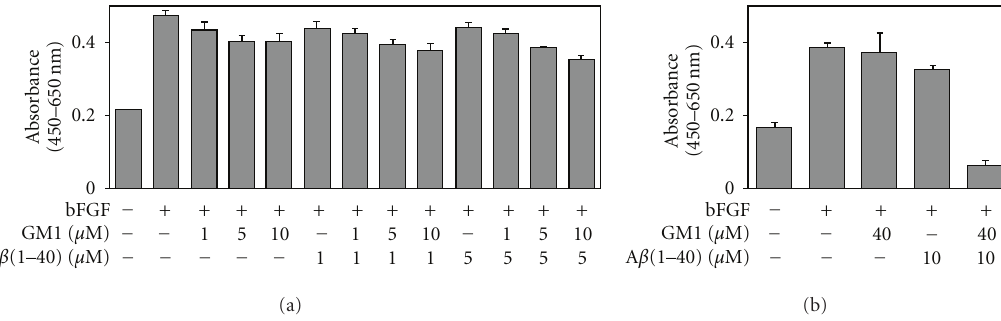
Figure 3: E ff ects of low (a) and high (b) concentrations of GM1 and A β 1–40 on NECs. Basic fibroblast growth factor (bFGF; 0 or 5ng/mL) was added as a mitogen of NECs. The number of NECs cultured in the presence of bFGF for 4 days was estimated by WST-8 assay with (a) GM1 (0, 1, 5 or 10 μ M) and A β 1–40 (0, 1 or 5 μ M); with (b) GM1 (0 or 40 μ M) and A β 1–40 (0 or 10 μ M). The spectrophotometric absorbance (Abs.) measured at the wavelength of 450nm (reference, 650nm) by this assay is highly correlated with the number of living NECs [113]. (Reproduced from [114] with